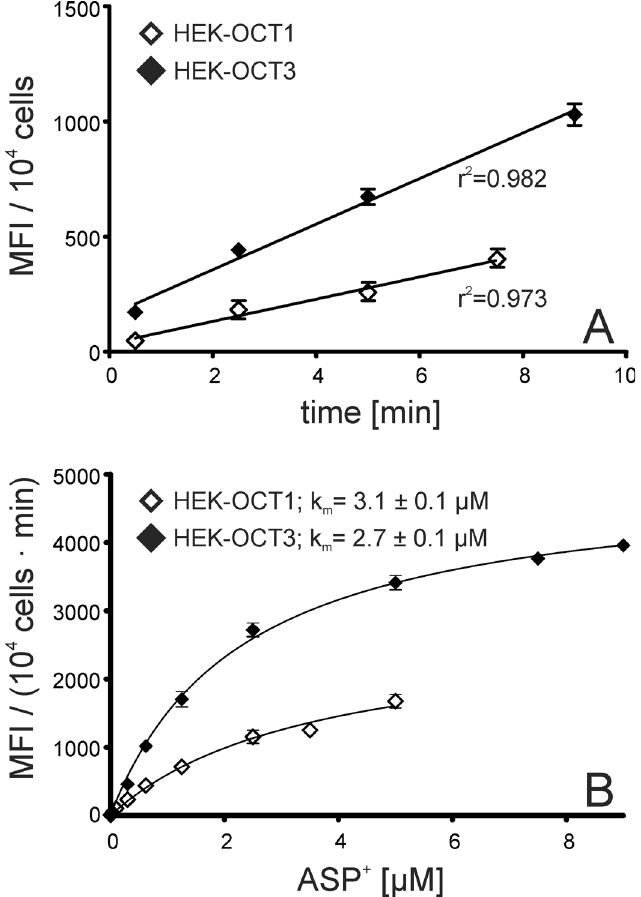
cells with 1 μ M ASP + (means ± SEM, N = 3). B: Concentration dependency of the initial velocity of the specific increase in the mean fluorescence intensity (MFI) caused by ASP + -uptake into HEK-OCT1 and HEK-OCT3 cells. HEK cells transfected with an empty vector served as control for unspecific uptake (means ± SEM, N =